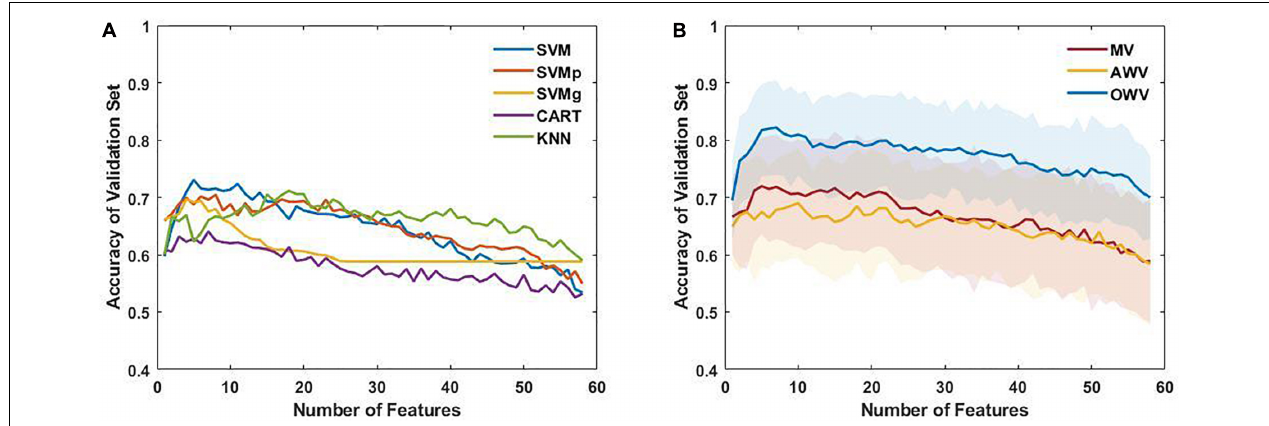
FIGURE 4 | (A) Mean accuracy of the single classifiers on the validation set, plotted as a function of the number of selected features. (B) Mean and standard deviation of the accuracy of the multiple classifiers (line and colored area, respectively) for each subset of features on the validation set. AWV, accuracy weighted voting; CART, classification and regression trees; KNN, K-nearest neighbors; OWV, optimum weighted voting; SVM, support vector machine; SVMg, support vector machine Gaussian kernel; SVMp, support vector machine polynomial kernel.